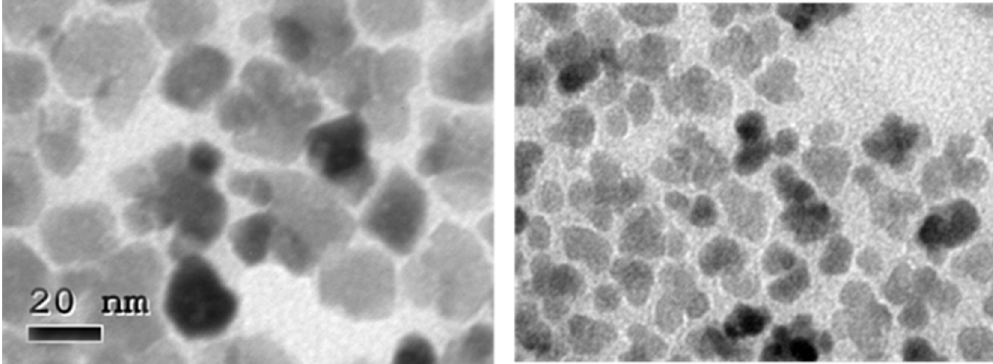
Figure 3. TEM images at higher magnification of aggregates of MNPs in a scaled sample (OR2, left) and in the unscaled sample (ORD6, right), both prepared with 30 min boiling time.